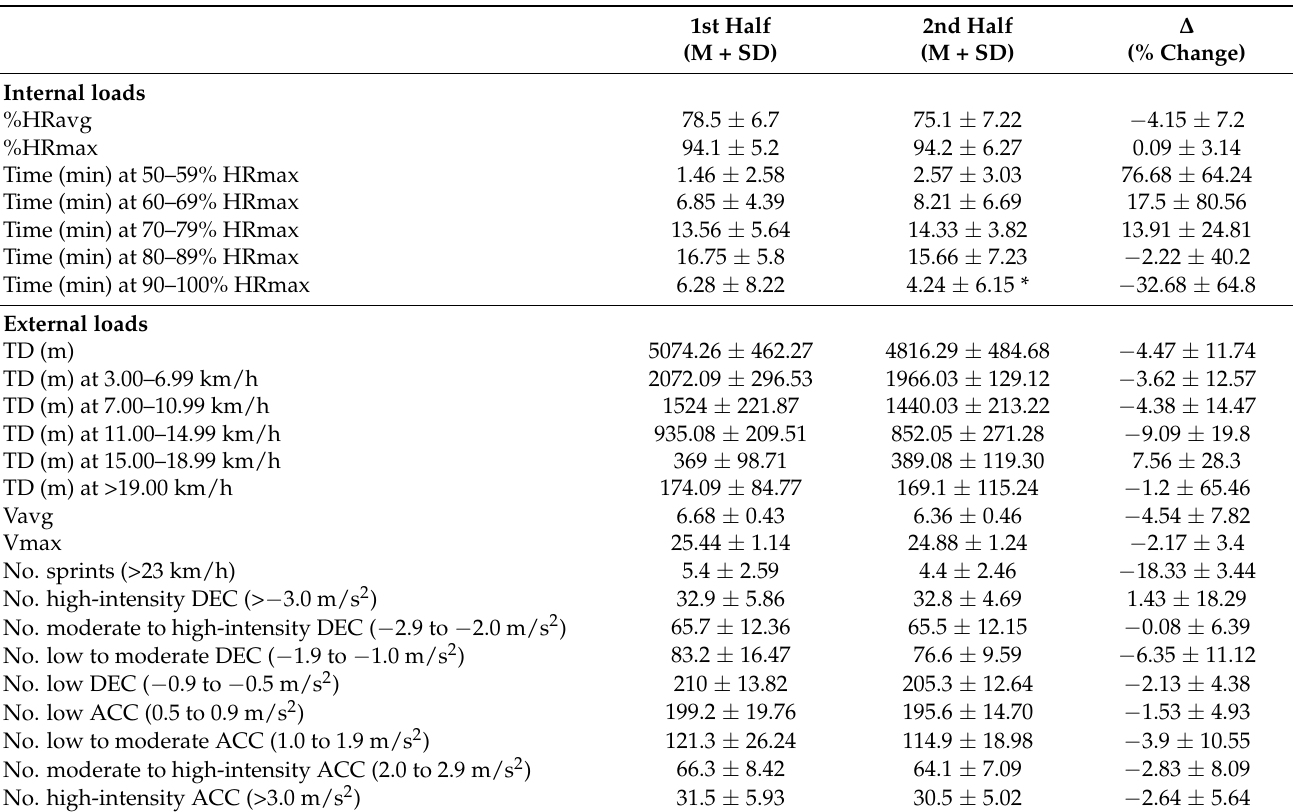
Table 1. Match-related internal and external